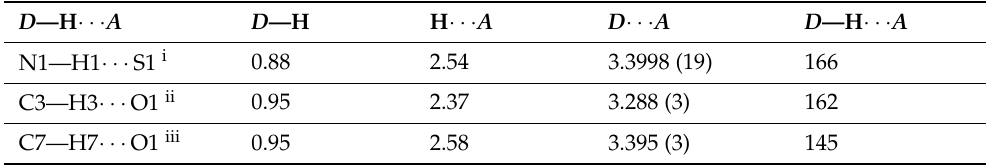
Figure 3. A partial packing diagram viewed down the b-axis. Hydrogen bonds are shown as dashed lines. The interatomic hydrogen bond distances were calculated for title compound and presented Table 2. Hydrogen-bond geometry (Å, ◦ ). in Table 3. It was observed that there was three D —H··· A (edge to face) interactions. Elabora- tion of these interactions is provided in Table 2. The N1 present in pyrimidine ring act as hydrogen bond donor to S1 of a molecule. The C3 of phenyl ring acts as hydrogen bond donor via H3 to O1 of the molecule. Similarly, C7 was also acting as hydrogen bond donor via H7 to O1 of molecule.